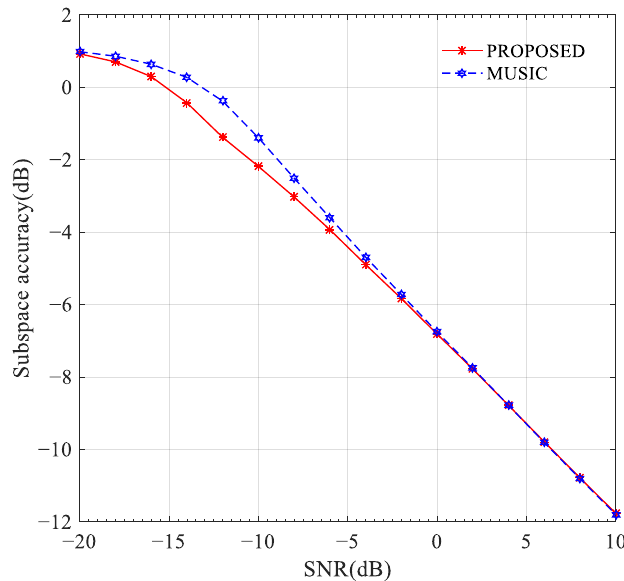
Figure 1. Accuracy of signal subspace versus SNR.